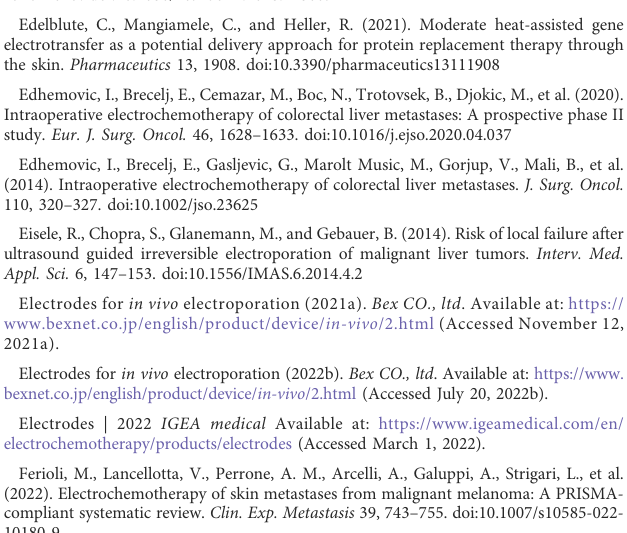
Figini, M., Wang, X., Lyu, T., Su, Z., Procissi, D., Yaghmai, V., et al. (2017). Preclinical and clinical evaluation of the liver tumor irreversible electroporation by magnetic resonance imaging. Am. J. Transl. Res. 9, 580 – 590. Fixed Electrodes (2022a). EPS series | IGEA medical . Available at: https://www. igeamedical.com/en/electrochemotherapy/products/electrodes/ fi xed-eps-series (Accessed July 7,